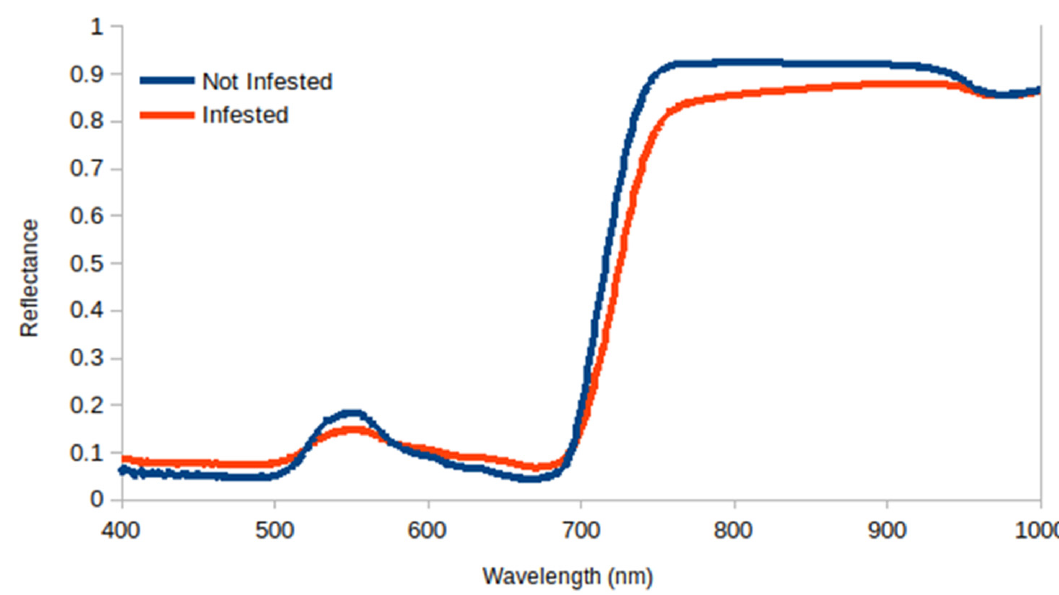
Figure 3. Typical spectral reflectance curves from EAB-infested and non-infested trees. Major diagnostic regions appear in the visible (400–700 nm) region, in the transitional region between visible and near-infrared light (700–900 nm), both regions where leaf photochemical pigments are the main controllers of reflectance. Spectral response beyond 900 nm is mainly controlled by leaf structure and water content, and is therefore less likely to yield information about leaf stress affecting pig- ments.